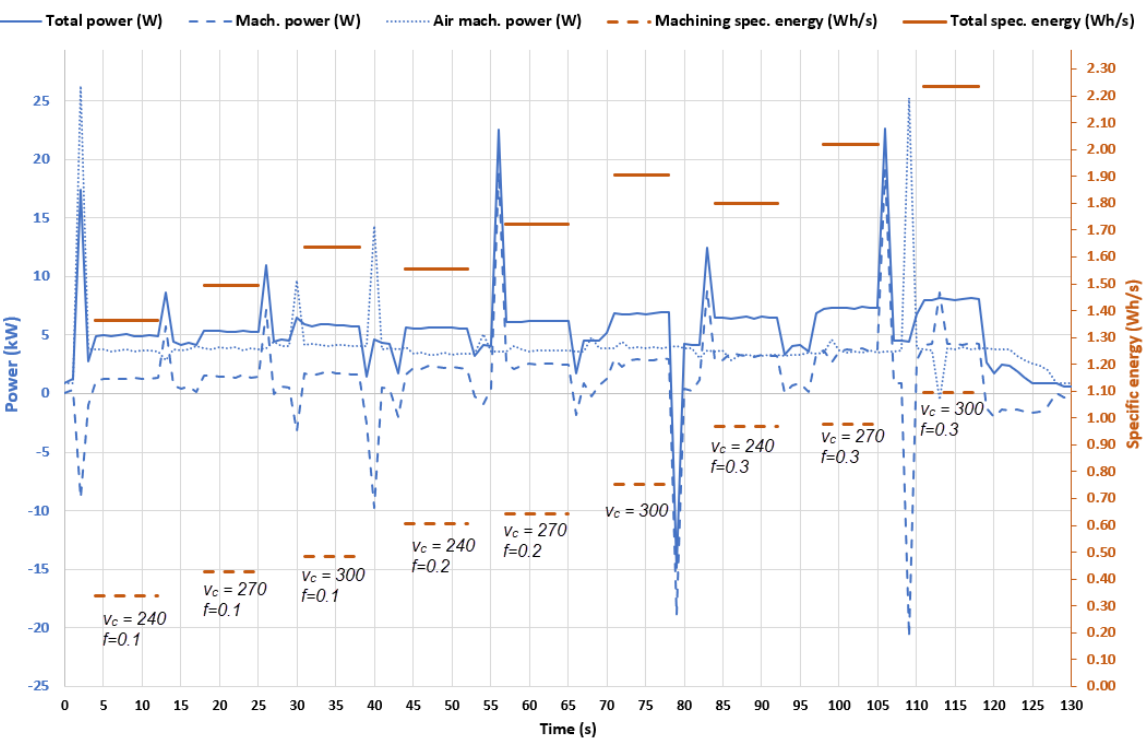
Figure 8. Total engaged power and mean specific energy consumption for the air-machining mode and machining mode for the workpiece machined with the depth of cut of 1 mm.